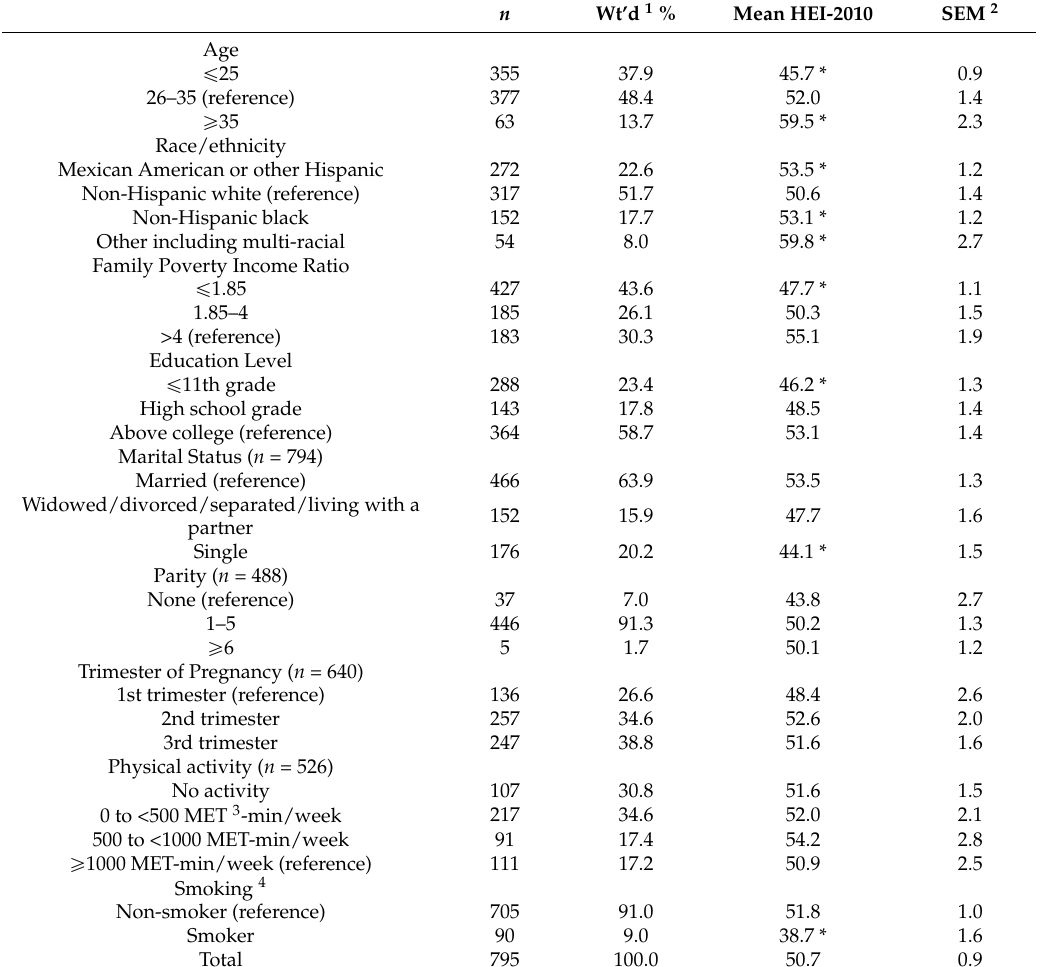
Table 2. The mean Healthy Eating Index (HEI)-2010 scores by maternal characteristics ( n =